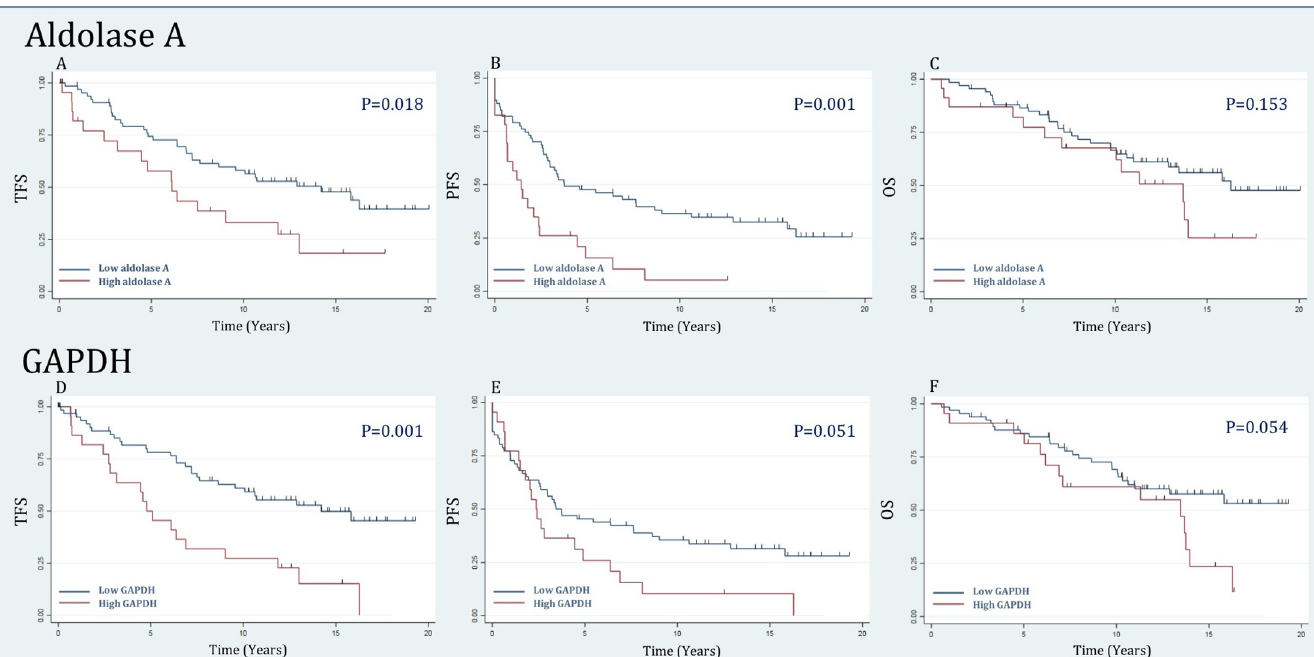
Fig 2. Outcome analysis. High levels of aldolase A expression were found to be associated with a significantly shorter transformation free survival (TFS) (p = 0.018) (A) and shorter progression free survival (PFS) (p = 0.001) (B). Furthermore, high levels of GAPDH expression were found to be associated with a significantly shorter TFS (p = 0.001) (D) and a trend towards shorter PFS (p = 0.051) (E). Overall survival was not significantly associated with either aldolase A and GAPDH expression levels (C and F). The low aldolase A expression group (n = 67) included 44 nt-FL and 23 s-FL patients, whereas the high aldolase A expression group (n = 23) consisted of 5 nt-FL and 18 s-FL (Table 1). The low GAPDH expression group (n = 66) included 44 nt-FL and 22 s-FL patients whereas the high GAPDH expression group (n = 22) consisted of 5 nt-FL and 17 s-FL (Table 1). FL, follicular lymphoma; GAPDH, glyceraldehyde-3-phosphate dehydrogenase; OS, overall survival; PFS, progression free survival; TFS, transformation free